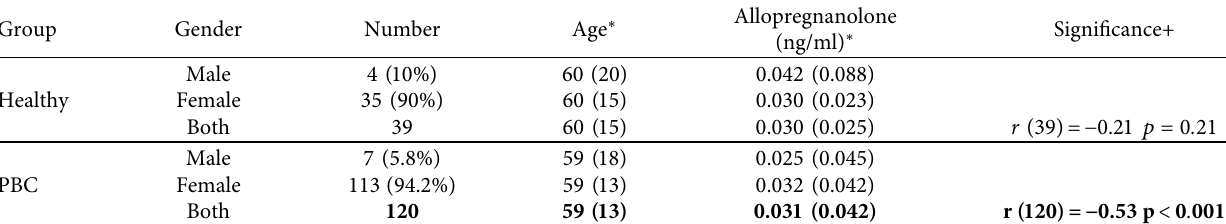
Table 2: Allopregnanolone levels (ng/ml) by, group, gender, and age. Group